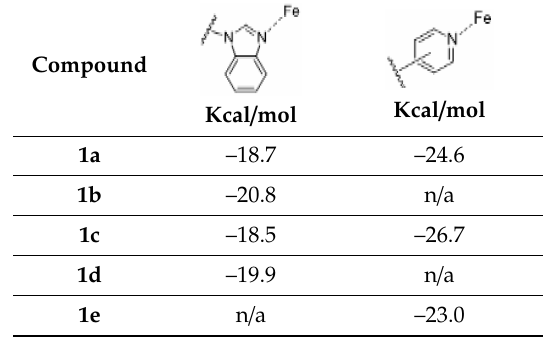
Table 2. Average binding free energy of compounds 1a - 1e with two possible binding modes. n / a—non